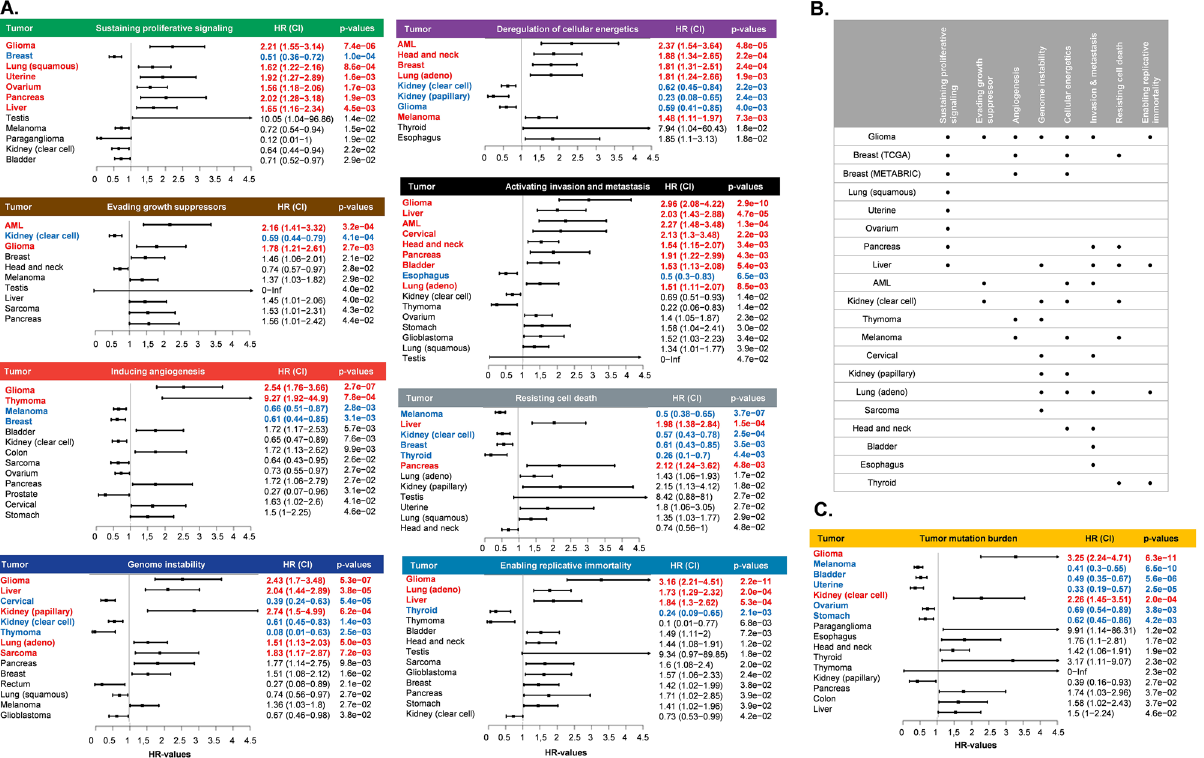
Figure 3. Effect of hallmark signatures ( A ) and tumor mutation burden ( C ) on patient survival. Summary of the significant prognostic hallmark signatures in different types of tumors ( B